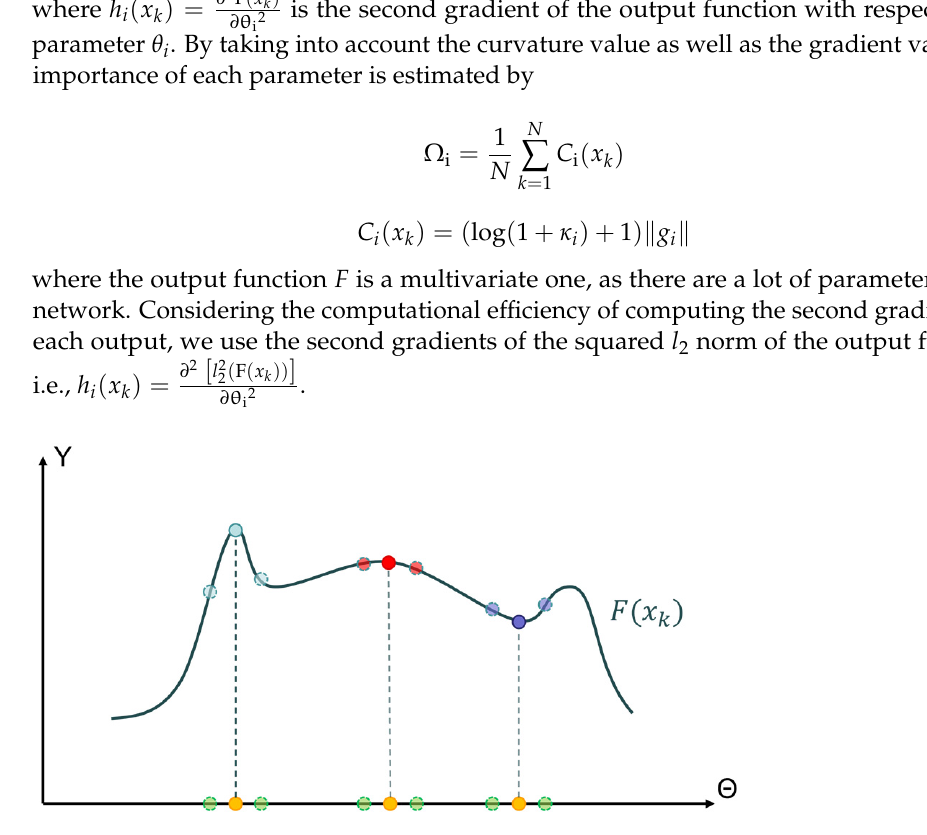
Figure 2. The illustration of MAS estimates the parameter importance based on the gradient, i.e., the sensitivity of the output function to parameter change. The gradient of output Y with respect to the parameter θ i evaluated at a given data point x k is used to measure the importance of this parameter.